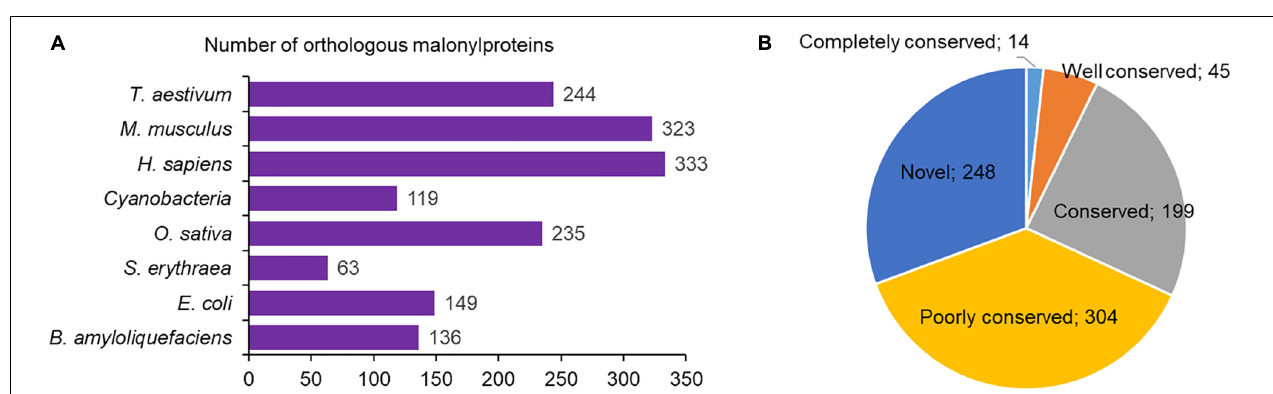
FIGURE 8 | Conservation of the modified malonylproteins. (A) Number of orthologous proteins in eight malonylomes reported previously. (B) A pie chart illustrating the conservation of malonylated proteins in H. sapiens , B. amyloliquefaciens , Cyanobacteria , E. coli , S. erythraea , O. sativa , M. musculus , and T. aestivum . The groups were classified as follows: Completely conserved, eight orthologs; Well conserved, six to seven orthologs; Conserved, three to five orthologs; Poorly conserved, one to two orthologs; Novel, zero orthologs.